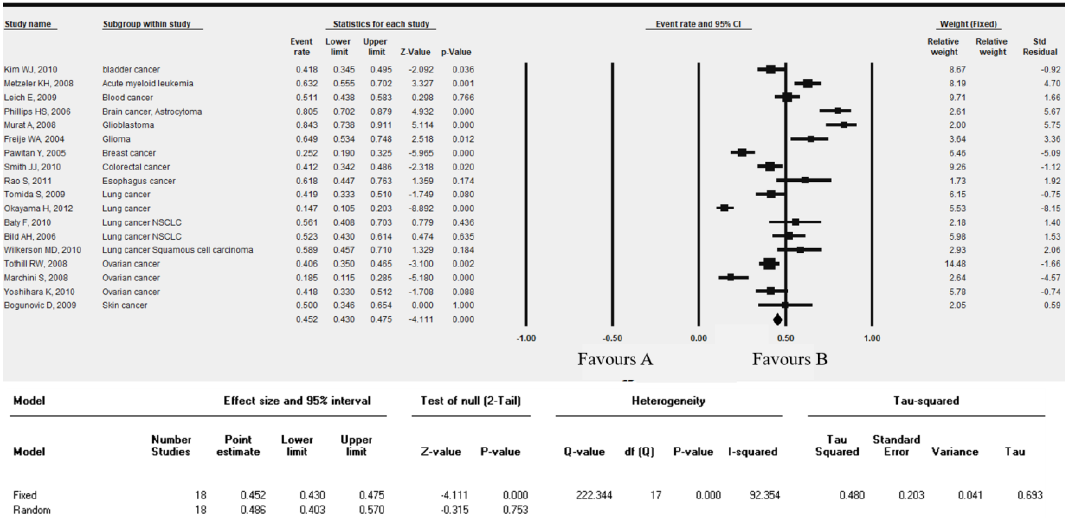
Figure 4. The association of SERTAD1 expression with patient’s survival and death hazard ratio (HR). Forest plot representing meta-analysis of SERTAD1 levels and its efficacious role in cancer invasiveness and clinical outcome. Effect sizes in the individual studies are indicated by the data markers, 95% confidence intervals are indicated by the error bars of HR.